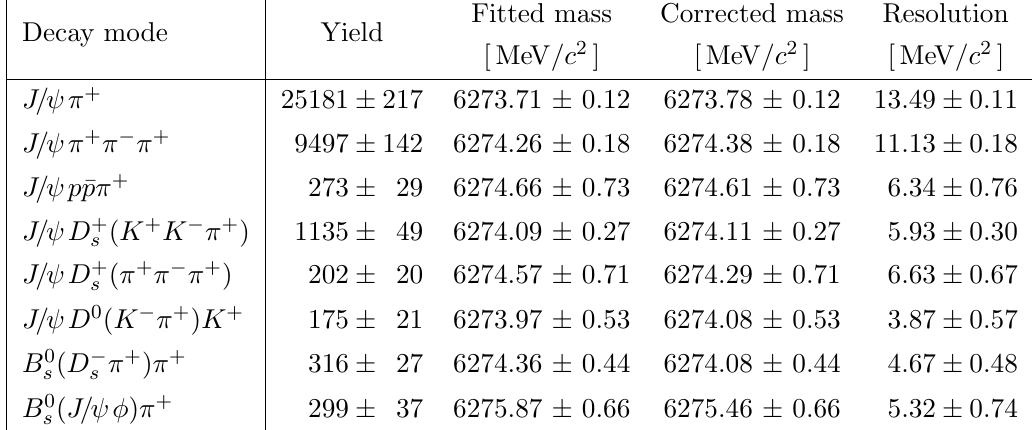
Table 1. Signal yields, mass values and mass resolutions as obtained from (cid:12)ts shown in (cid:12)gure 1, together with the mass corrected for the e(cid:11)ects of (cid:12)nal-state radiation and selection as described in the text. The uncertainties are statistical